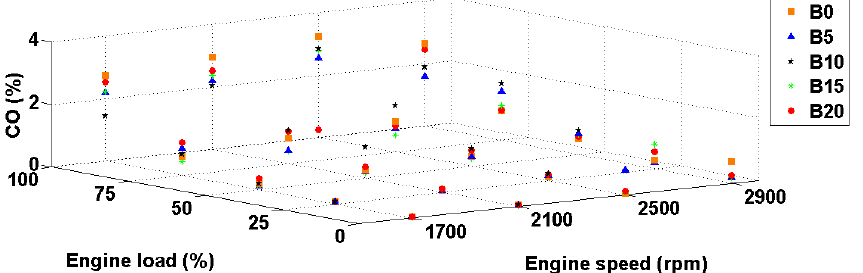
Figure 12. CO emission of the engine under different engine loads, speeds and biodiesel percentages.